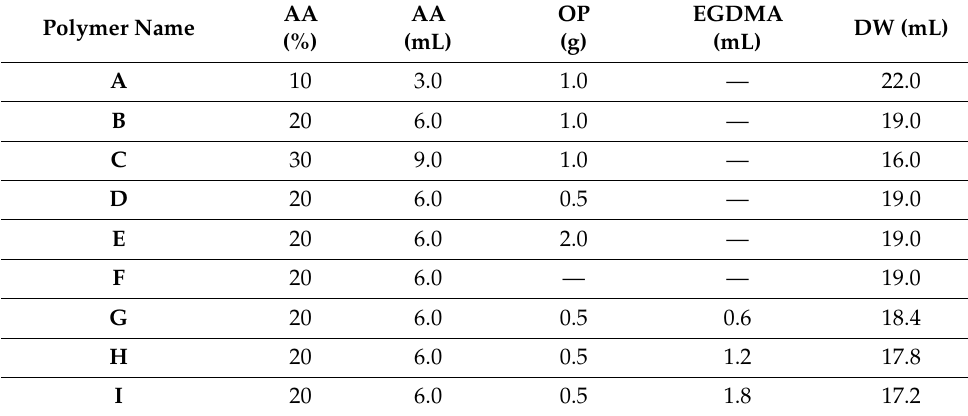
Table 1. OP-PAA Adsorbent hydrogel composite